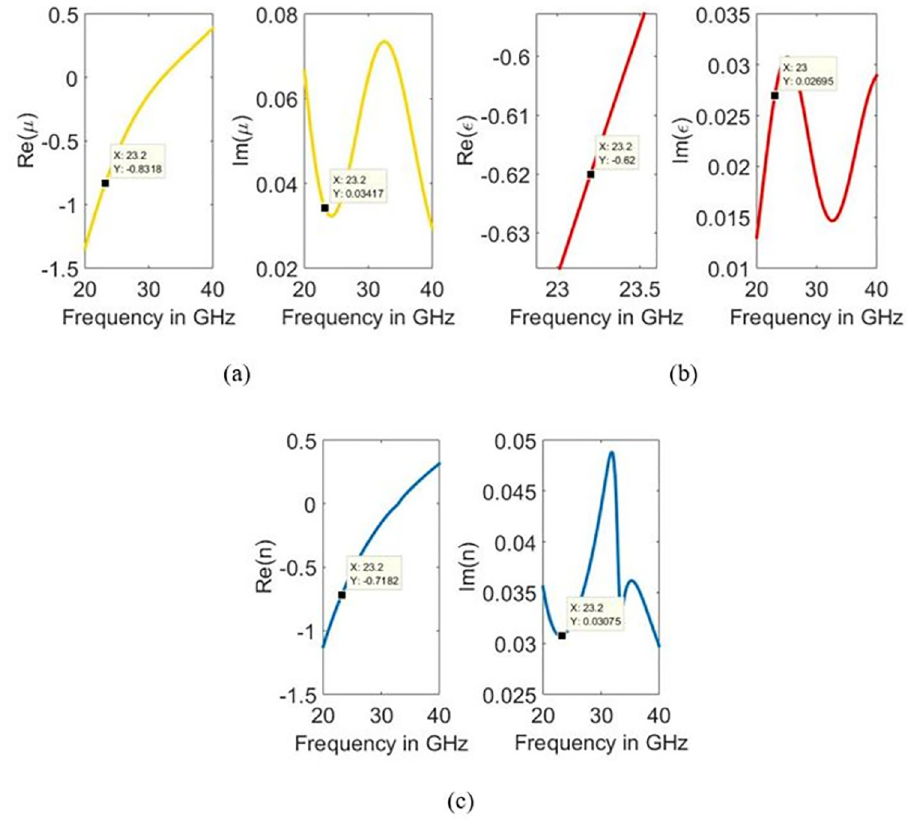
Fig 4. Extracted constitutive parameters of the structure (a) permittivity, (b) permeability, and (c) refractive index.